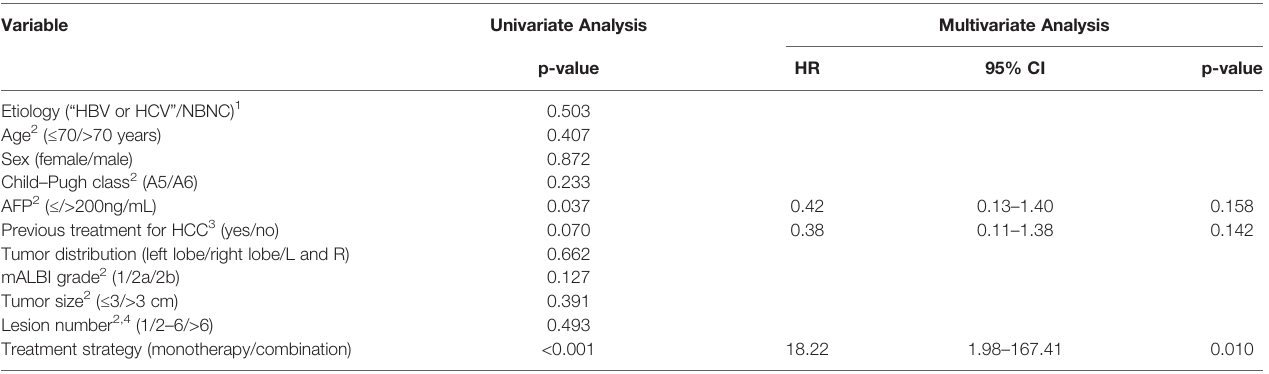
TABLE 3 | Univariate and multivariate analyses of factors associated with